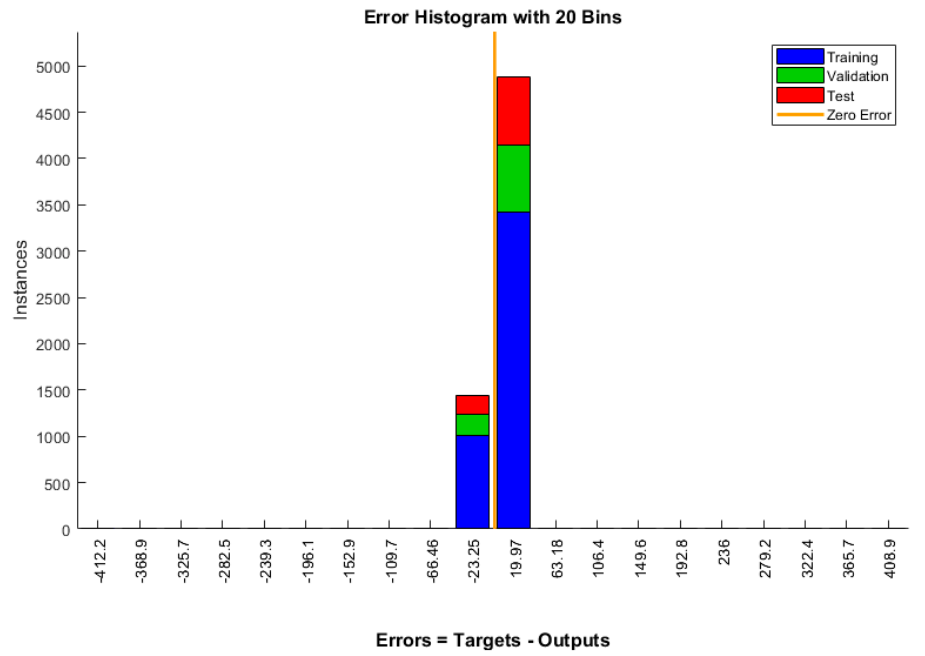
Figure 6. Error histogram of neural network training. 64 Energies 2020 , 13 , x FOR PEER REVIEW